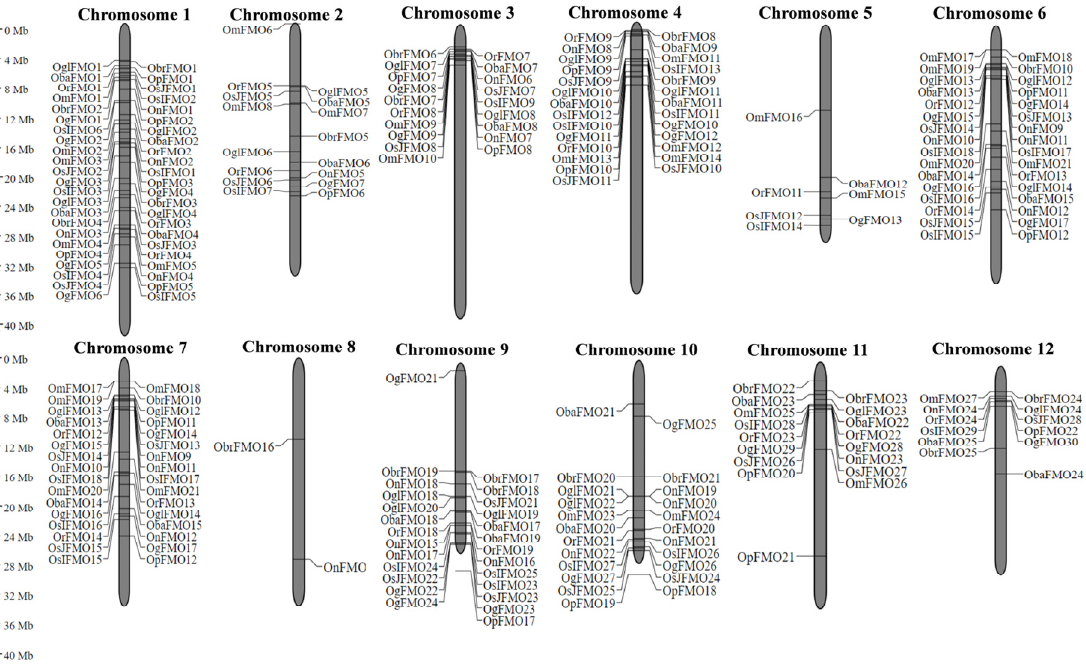
Figure 1. Chromosomal distribution of FMO genes in wild and cultivated rice. The distribution of the FMO genes on the twelve chromosomes of rice was determined using MapGene2Chromosome tool. The chromosome numbers are depicted on top of each chromosome. The position of each gene on the respective chromosome has been depicted in terms of megabase pairs by numbers beside each gene.